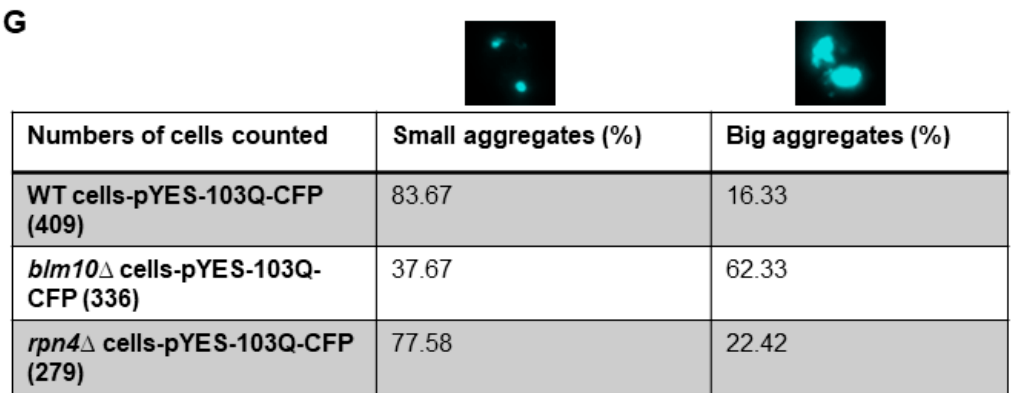
Figure 2. Expression and insoluble aggregate formation of toxic N-Htt in wt and blm10 ∆ cells following induction by galactose. ( A , B ) Expression of Htt103Q was induced by 2% galactose for the times indicated and native gel analysis was performed in wt and blm10 ∆ cells. Equal protein amounts (10 µ g) of the total lysates (T), supernatants (S), and aggregate-containing pellets (P) were loaded. Htt103Q levels were detected with an anti-GFP antibody. ( C ) Quantification of theHtt103Q insoluble fractions in wt and blm10 ∆ cells were normalized to the corresponding 10 h induction in each strain. Data are shown as mean values ± SD for three independent experiments. Data were analyzed using Image Lab software version 5.2.1. Statistical analysis was performed using ANOVA by GraphPad Prism 8.2.1. p < 0.05 was considered significant. ( D , E ) Expression of toxic Htt103Q causes increased Htt103Q aggregation upon loss of BLM10. Visualization of N-Htt aggregation in cells expressing Htt25Q-GFP or Htt103Q-GFP using live-cell microscopy is shown. Htt103Q and Htt25Q were visualized via a GFP fusion. Di ff erential interference contrast bright-field images (DIC) are presented to the left. Projected sequential Z - stack fluorescence images are presented. Scale bars 25 µ m (inset 10 µ M) ( F , G ) Quantification and classification of Htt103Q aggregates in wt, blm10 ∆ , and rpn4 ∆ cells. Data are shown as mean values ± SD for three independent experiments. The 409 wt, 336 blm10 ∆ , and 292 rpn ∆ cells were counted and analyzed. Statistical analysis was performed using ANOVA by GraphPad Prism 8.2.1. (**** indicates p < 0.0001).